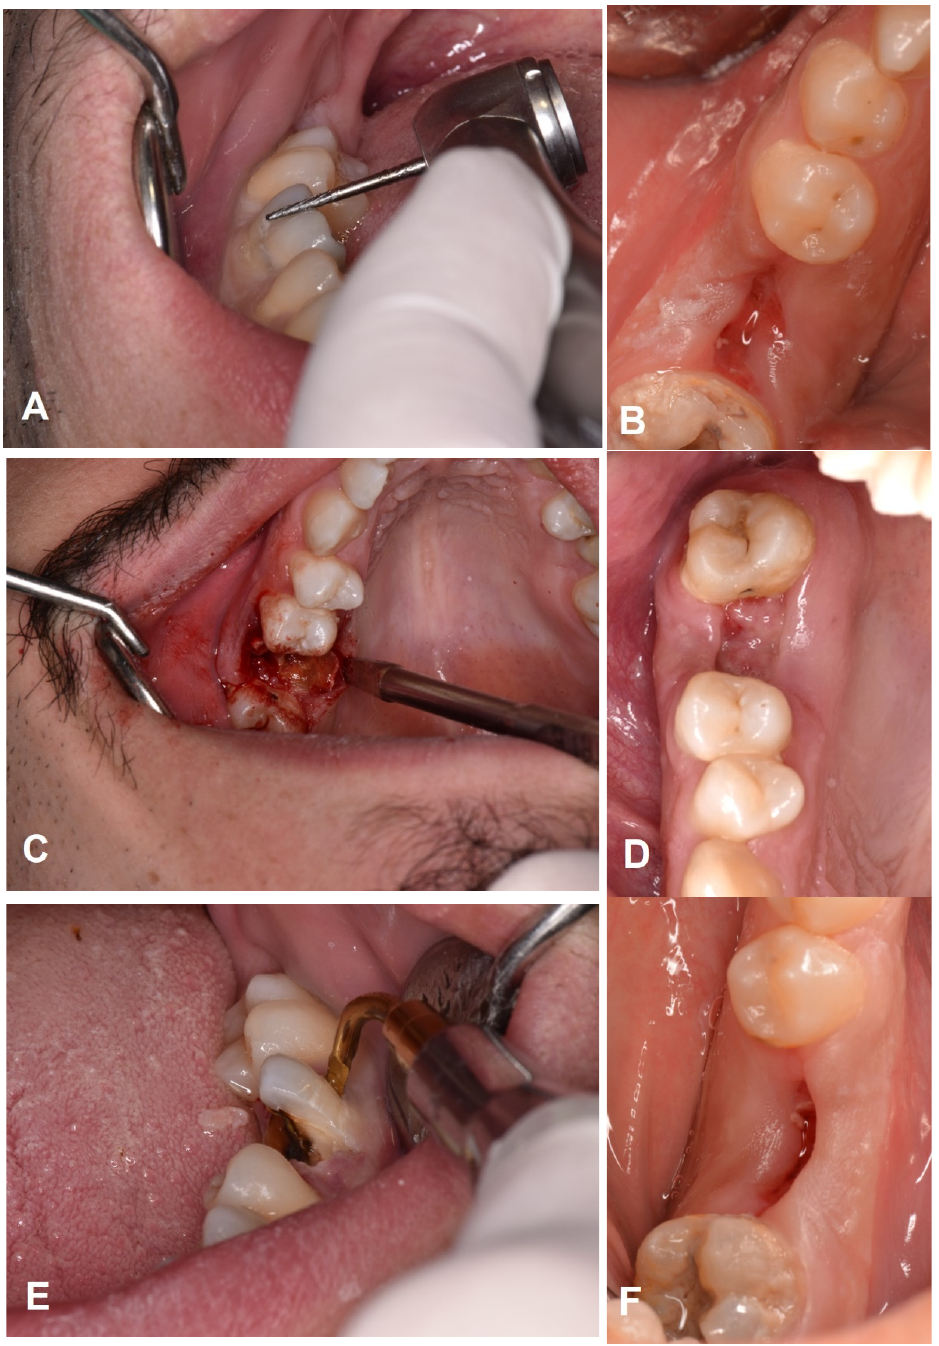
Figure 2. ( A ) Extraction of right mandibular first molar: control intervention (turbine with surgical bur). ( B ) Healing after suture removal. ( C ) Extraction of right maxillary first molar: Magnetic Mallet (EXTR 1) ( D ) Healing after ten days. ( E ) Extraction of right mandibular first molar: Piezosurgery (EX 1) ( F ) Healing at the follow ‐ up visit.